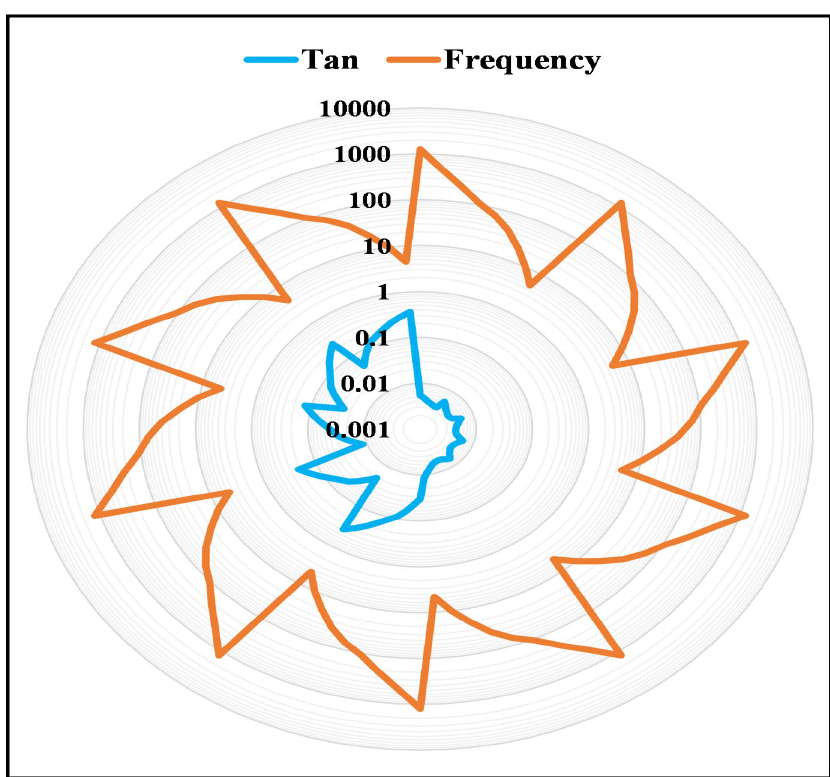
Figure 4. Radar plot of frequency and tan delta variations over the aging of transformer oil-paper insulation.